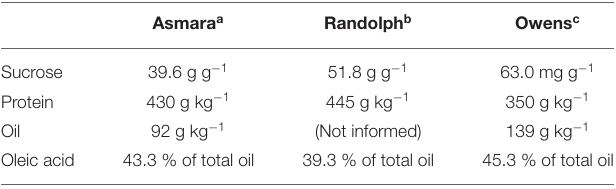
TABLE 1 | Edamame bean composition of three North American cultivars on a dry weight basis